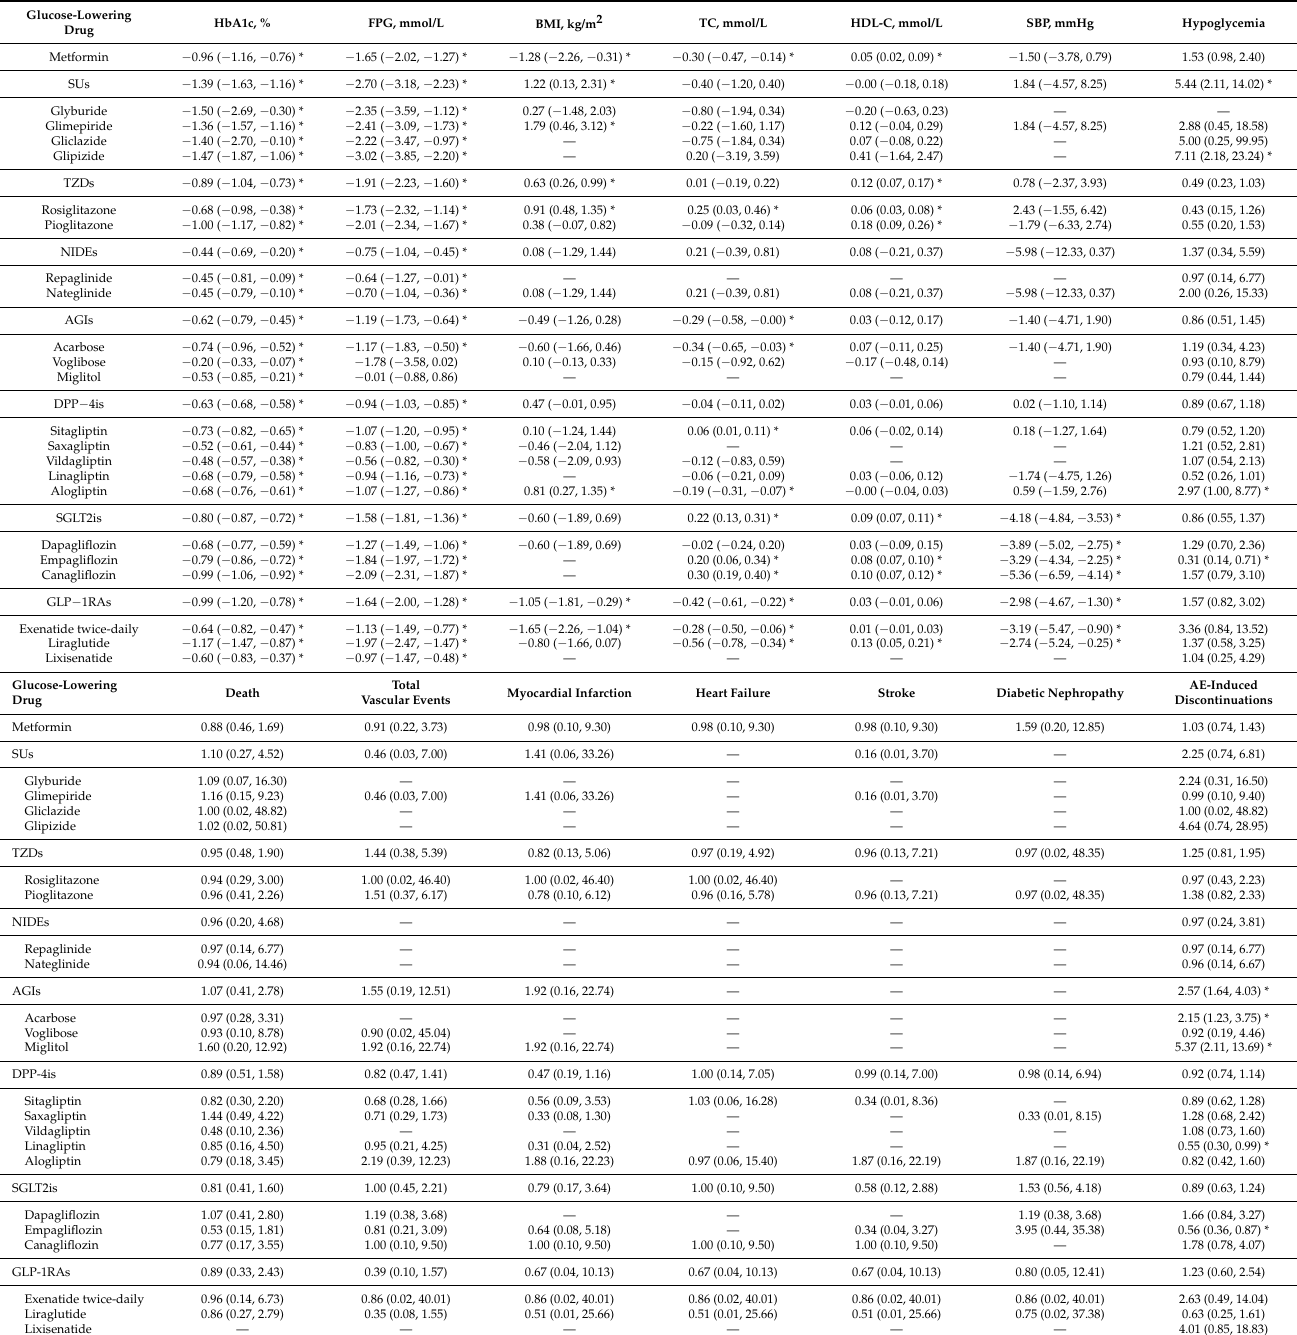
Table 1. Treatment effects of glucose-lowering drugs after removing the effect of placebo/lifestyle